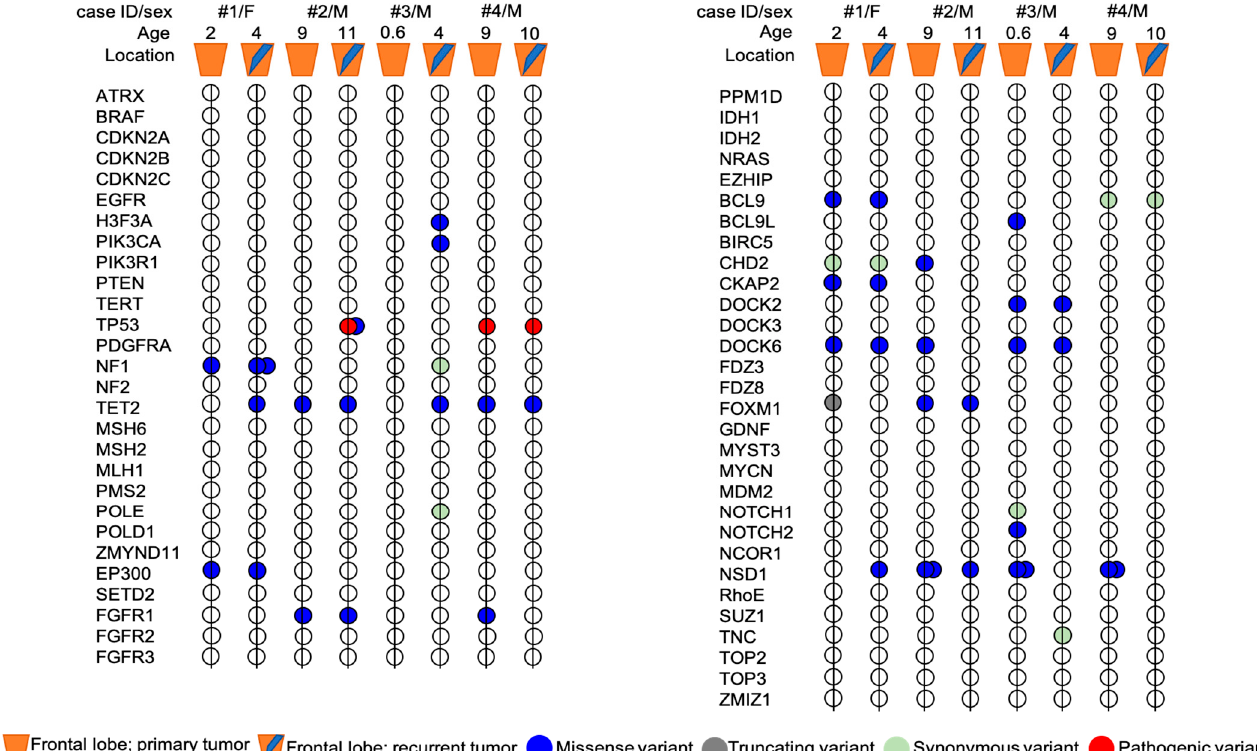
Figure 4. Mutational profile of primary and recurrent tumors pairs from four patients with pHGG. The exact HGVS nomenclature of each variant present in the primary tumor and/or in the relapse of each patient is shown in Figure 5. Age, sex and tumor location are indicated for each patient. Mutations are represented by colors: blue = missense, grey = truncating (frameshift), light green = synonymous, red =